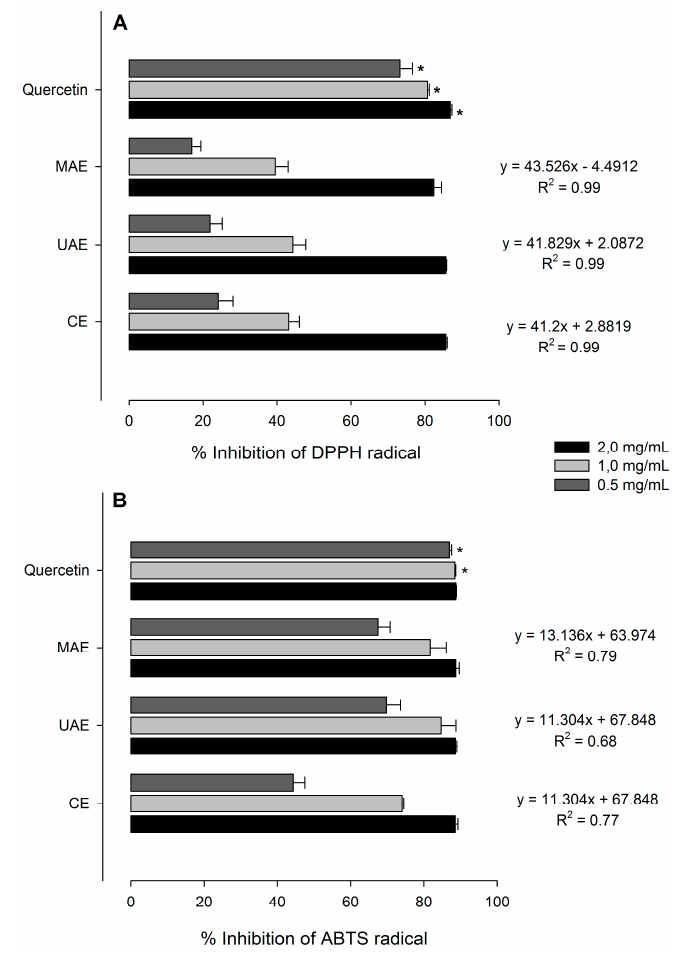
Figure 4. Antioxidant capacities on DPPH ( A ) and ABTS ( B ) free radicals of leaf extracts obtained from Nectandra grandiflora . * Indicate significant differences among the extraction methods and quercetin for the same concentration by Tukey test ( p < 0.05). CE: Conventional Soxhlet extraction; UAE: Ultrasound-